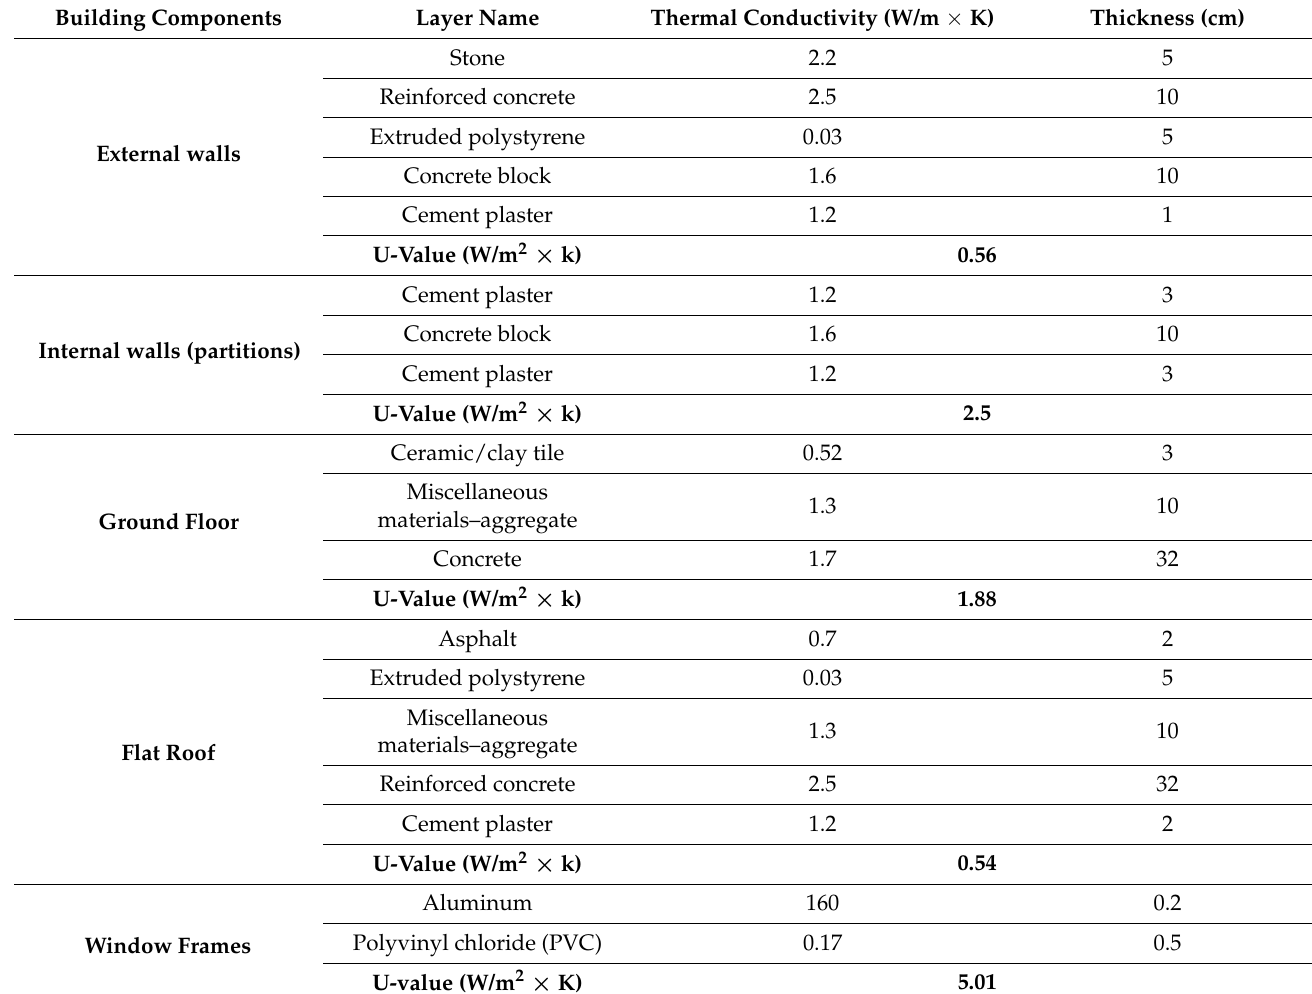
Table 2. Building materials’ thermal conductivity and their